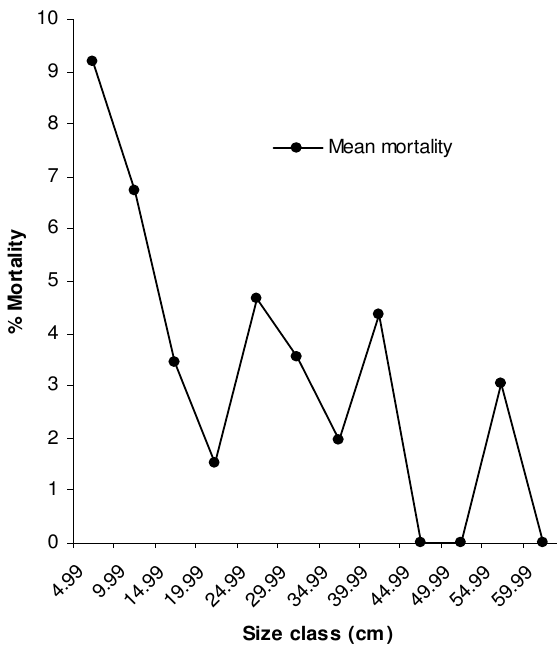
Fig. 4. Size class specific mortality observed in Kagekanu permanent